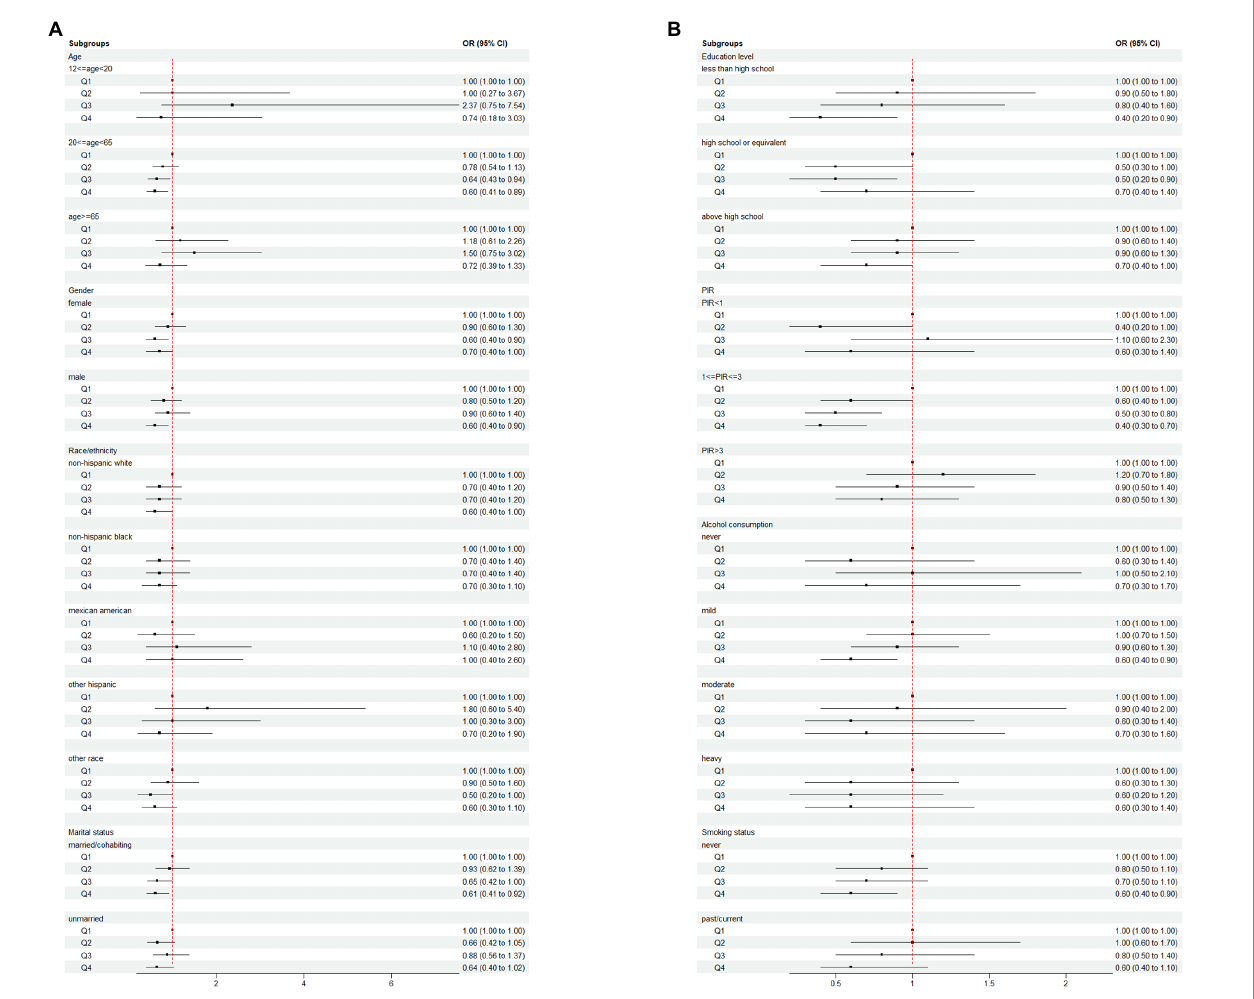
FIGURE 4 Subgroup analysis of the association between daidzein intake and the prevalence of MAFLD plotted in ( A ) and ( B ). MAFLD, metabolic associated fatty liver disease; Q, quartile; PIR, family income-to-poverty